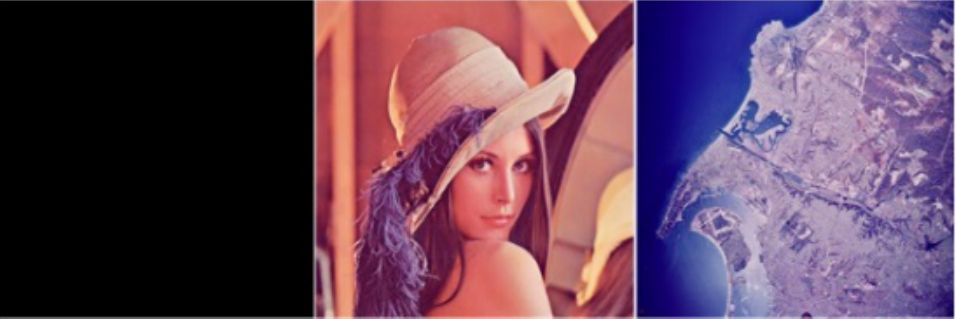
Figure 6. Experimental image.